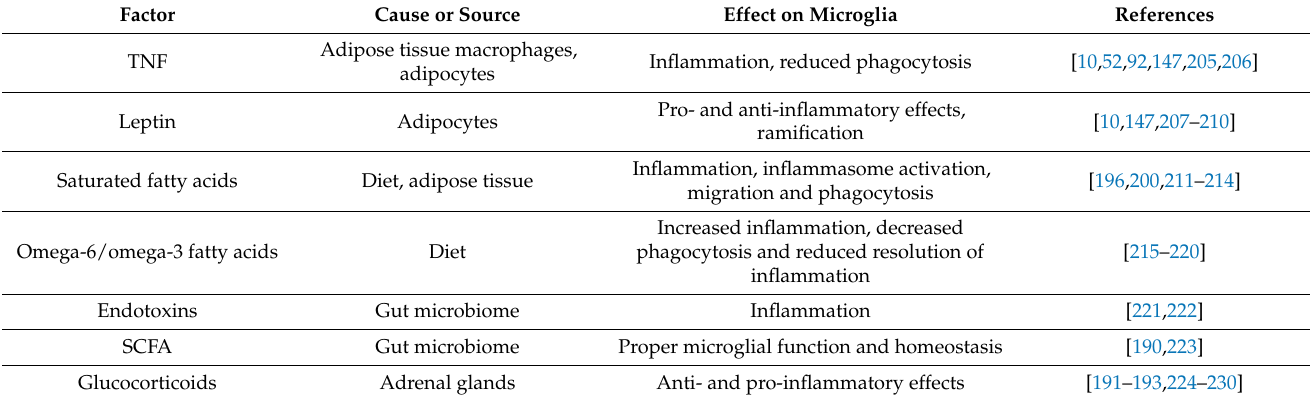
Table 1. Factors that are discussed as mediators of the effects of obesity on microglia-mediated neuroinflammation. Factor Cause or Source Effect on